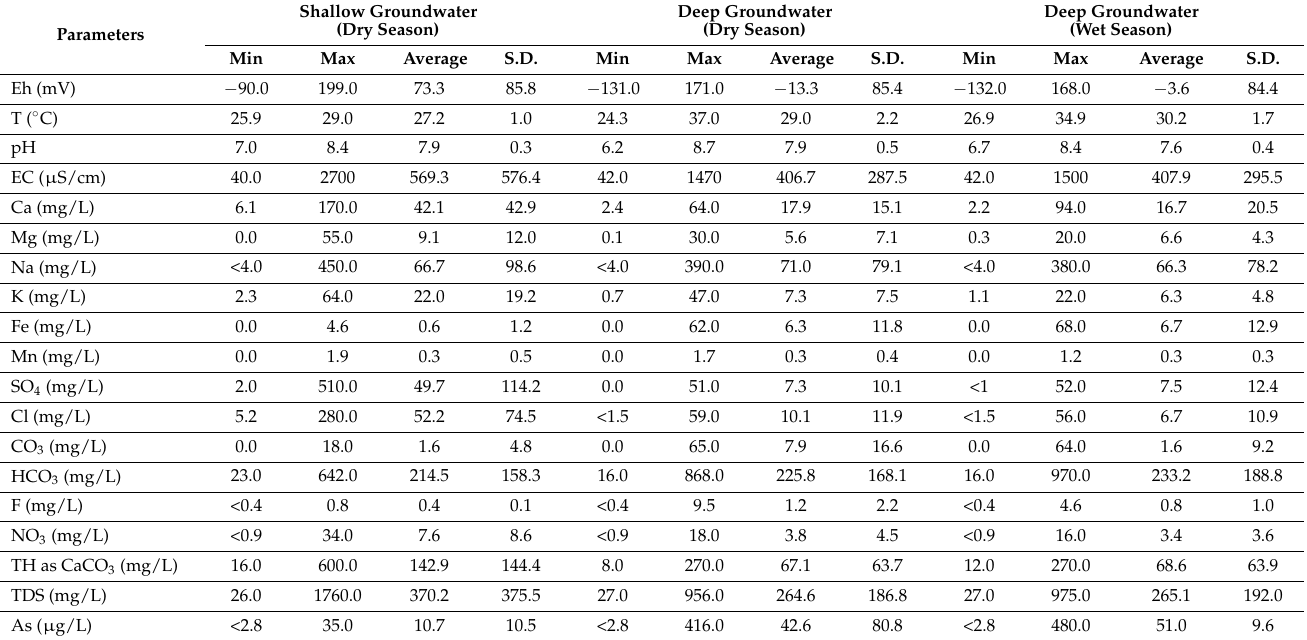
Table 1. Shallow and deep groundwater chemical constituents and their physicochemical